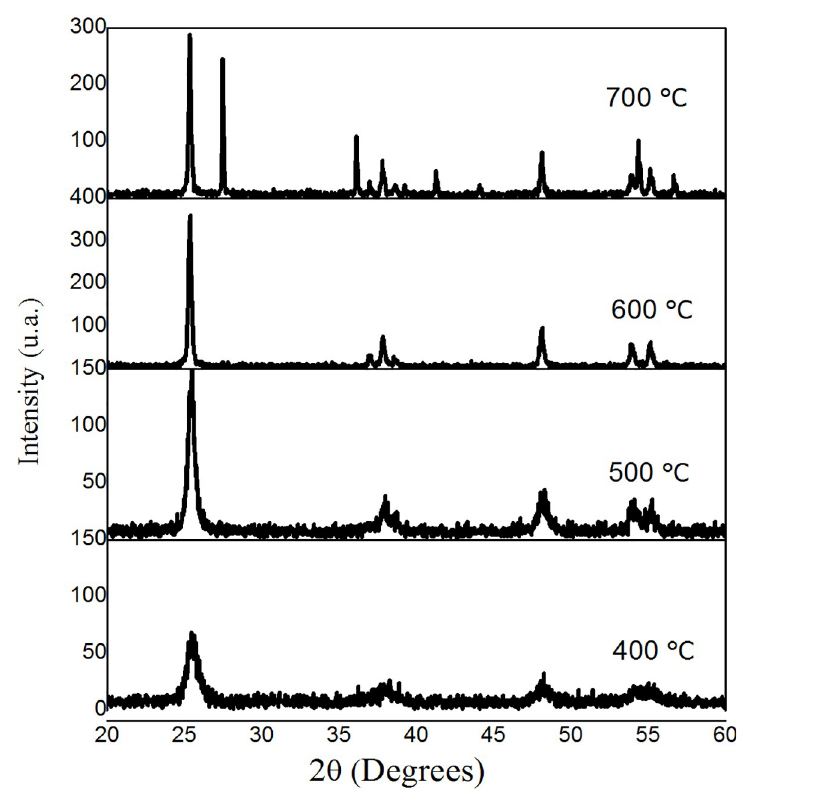
Fig 4. X-ray diffractograms of TiO 2 powder samples.